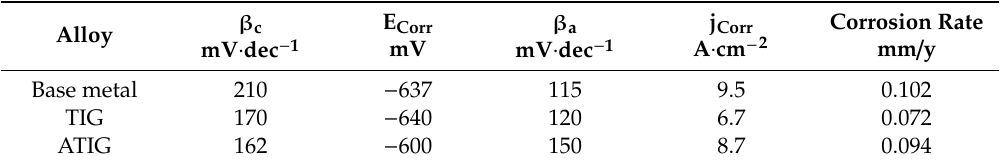
Table 15. Potentiodynamic polarization data obtained for the di ff erent materials after 1 h immersion in 3.5% NaCl